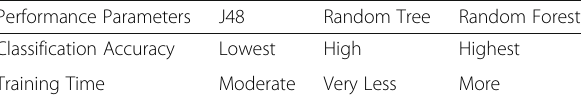
Table 6 Summary of comparison of overall performance of the Data Mining